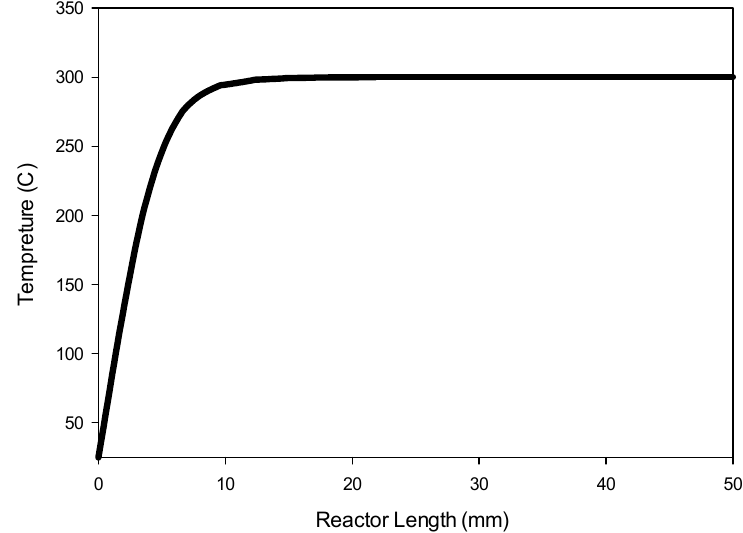
Reactor Length (mm)